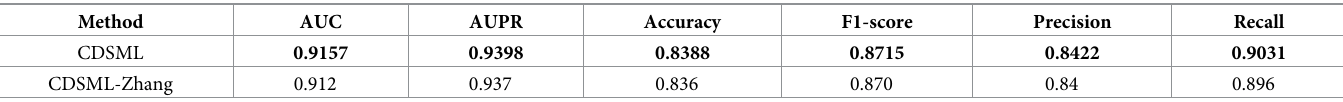
Table 5. Comparison of CDSML and CDSML-Zhang performance on GDSC dataset. The assessments were done by averaging 30 repetitions of stratified five-fold cross-validation. The highest value of each criterion is shown in bold.